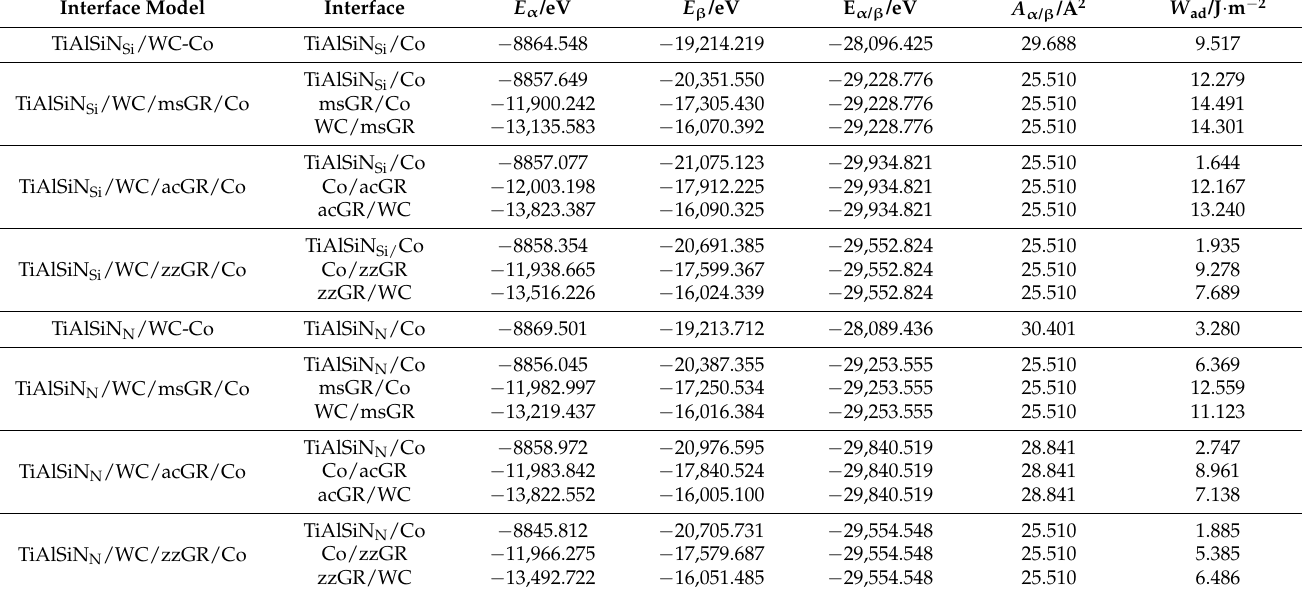
Table 2. Adhesion works of matrix doped with intrinsic graphene.